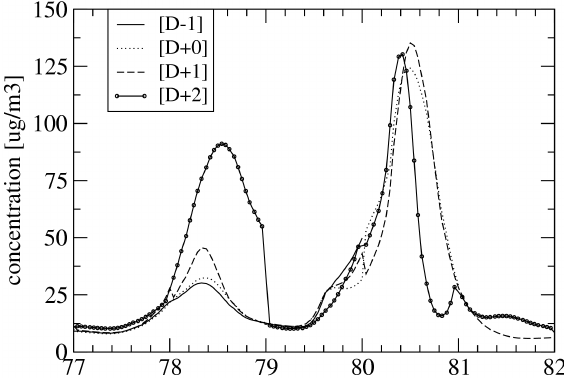
Fig. 17. Time series of dust forecast for the period of 17 to 23 March 2006. The results are for dust surface concentrations in Rome, Italy.